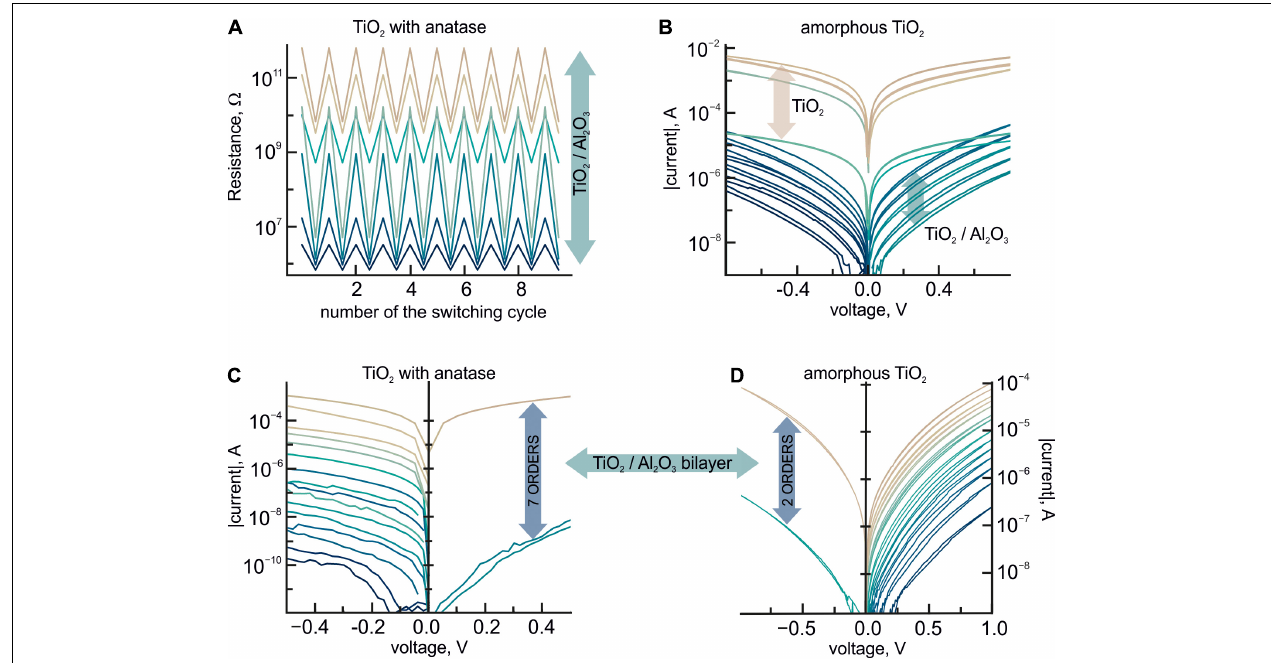
FIGURE 2 | (A) R OFF /R ON ratio for seven different resistance states of the Pt/TiO 2 /Al 2 O 3 /Pt bilayer structures with amorphous titanium dioxide layer with the inclusion of the anatase phase crystallites in the dependence on the switching cycle. The color on the figure corresponds to the resistance state of the bilayer structure, relative to which the coexistence of the bipolar resistance switching with the R OFF /R ON ratio could be observed. The R OFF /R ON ratio was determined for a bipolar resistive switching relative to the given resistance state for the Pt/TiO 2 /Al 2 O 3 /Pt structure [switching resistance from a high resistive state (HRS) to a low resistive state (LRS) happens when a negative voltage is applied to the Pt-TE], whereas the reset process (switching the resistance from an LRS to an HRS) occurs at a positive voltage (i.e., clockwise switching). The OFF-resistance/ON-resistance ratio for a certain resistance state is shown with a certain color. The transition between different resistance states was tuned in DC operation mode by current–voltage sweep in the range of –2.0 to –4.0 V. The resistance of the bilayer structure was measured by using a low (0.1 V) dc voltage. (B) The analog switching of the resistance state of the Pt/TiO 2 /Al 2 O 3 /Pt bilayer structures with amorphous titanium dioxide layer in the range of two orders of magnitude. An irreversible transformation of the aluminum oxide layer in the bilayer structures leads to a bipolar resistance switching typical for titanium dioxide shown above the range of the analog switching. (C) Experimental I-V characteristics of analog tuning of the resistance of Pt/TiO2/Al2O3/Pt bilayer structures with tiatanium dioxide layer with the inclusion of the anatase phase crystallites. (D) Experimental I-V characteristics of analog tuning of the resistance of Pt/TiO2/Al2O3/Pt bilayer structures with amorphous tiatanium dioxide